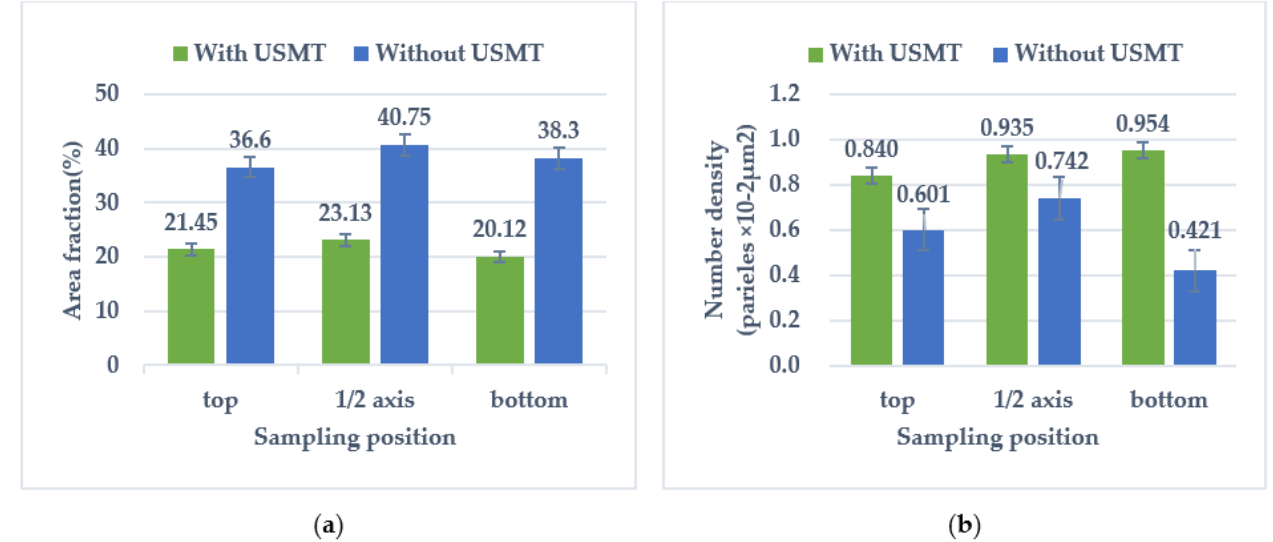
Figure 6. ( a ) Area fraction of the coarsening eutectic phase; and ( b ) the density of the precipitated particles in ingots with and without USMT.